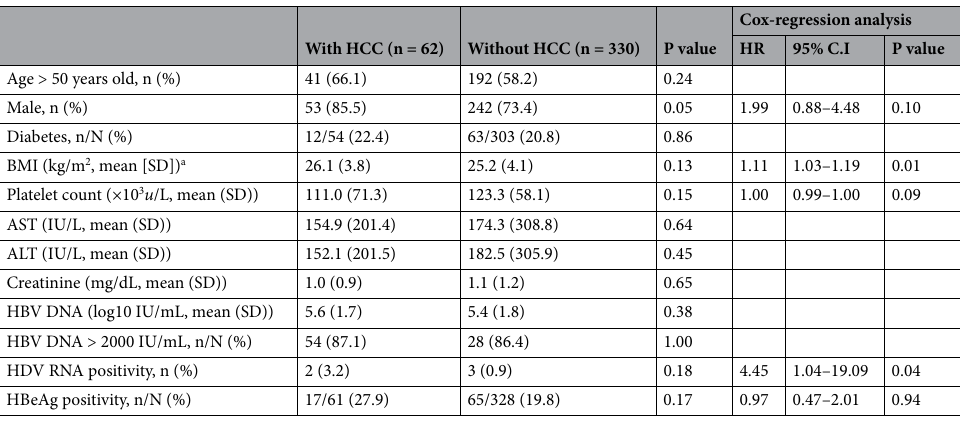
Table 3. Factors associated with the new onset of HCC after HBV NAs use in cirrhotic patients. SD: standard deviation; BMI: body mass index; AST: aspartate aminotransferase; ALT: alanine aminotransferase; HBsAg: hepatitis B surface antigen; HBV: hepatitis B virus; HDV: hepatitis D virus; HBeAg: hepatitis B e-antigen; FIB-4: fibrosis-4 index; HCC: hepatocellular carcinoma; NAs: nucleotide analogues; HR: hazard ratio; CI: confidence interval. a n =